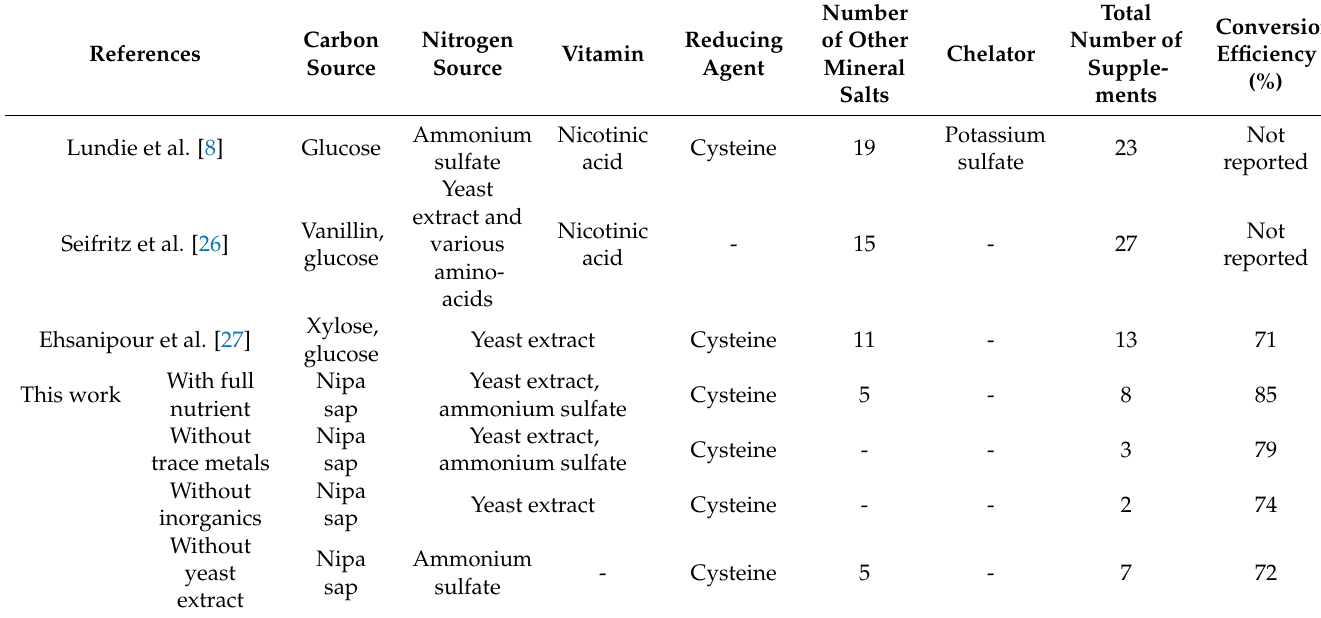
Table 5. Comparison of total number of supplements used for fermentation with M. thermoacetica